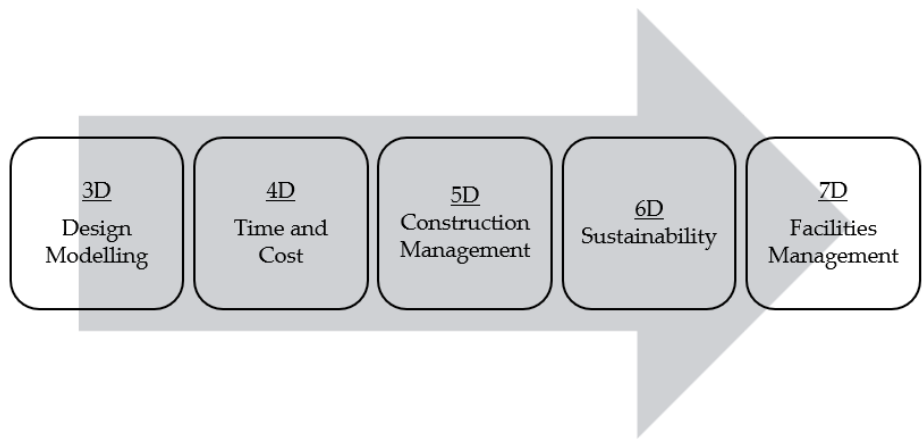
Figure 3. Overview on the different dimensions of BIM where it can be used. Figure modified from [21,23].